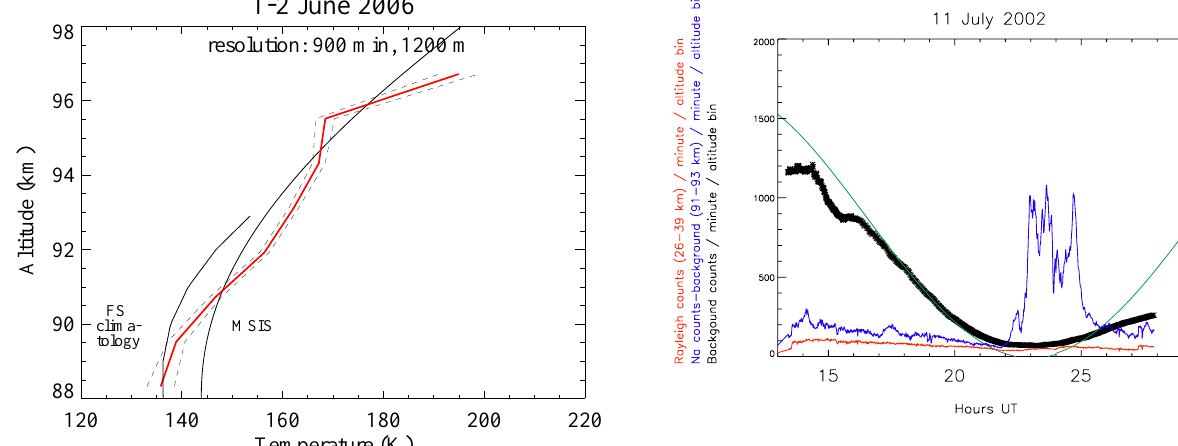
Fig. 6. The integrated Na counts from an altitude interval from 91 to 93km, is plotted in blue against the measuring time. The background is plotted in black and the solar elevation angle in green. The Rayleigh signal is given in